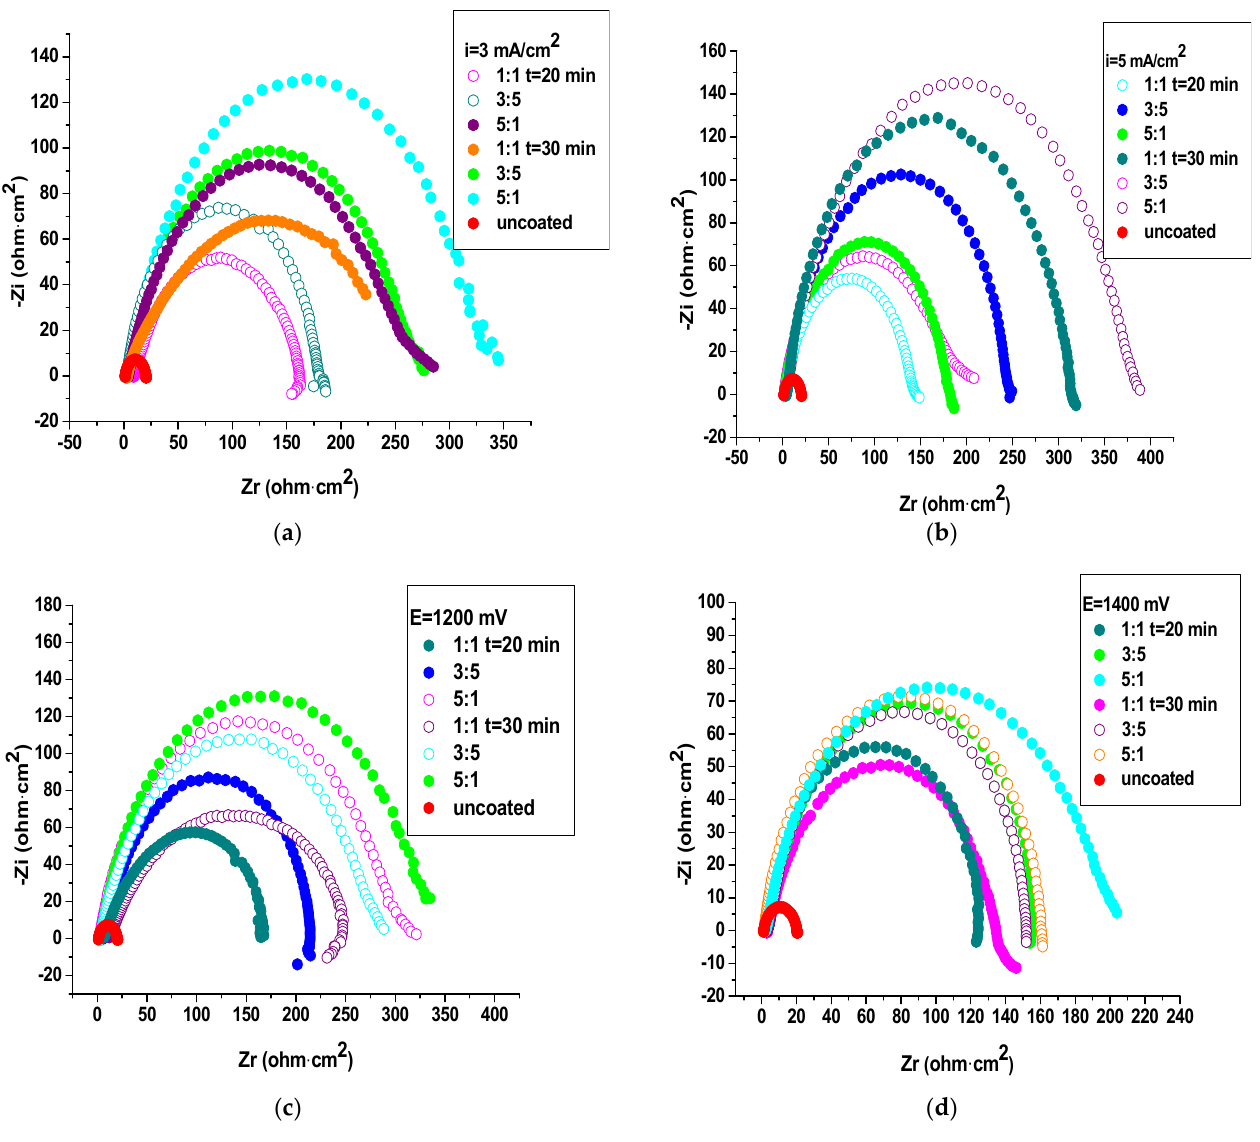
Figure 8. Nyquist graphs for uncoated and PNMPY-TW20/P3MT-coated OLC 45 sample by galvanostatic, at ( a ) 3 mA/cm 2 and ( b ) 5 mA/cm2 current density, and potentiostatic, at 1.2 V ( c ) and 1.4 V ( d ) potential, procedures with diverse molar ratio for PNMPY-TW20 and P3MT. The Bode graphs of PNMPY-TW20/P3MT coating (Figure 9) divulged that the